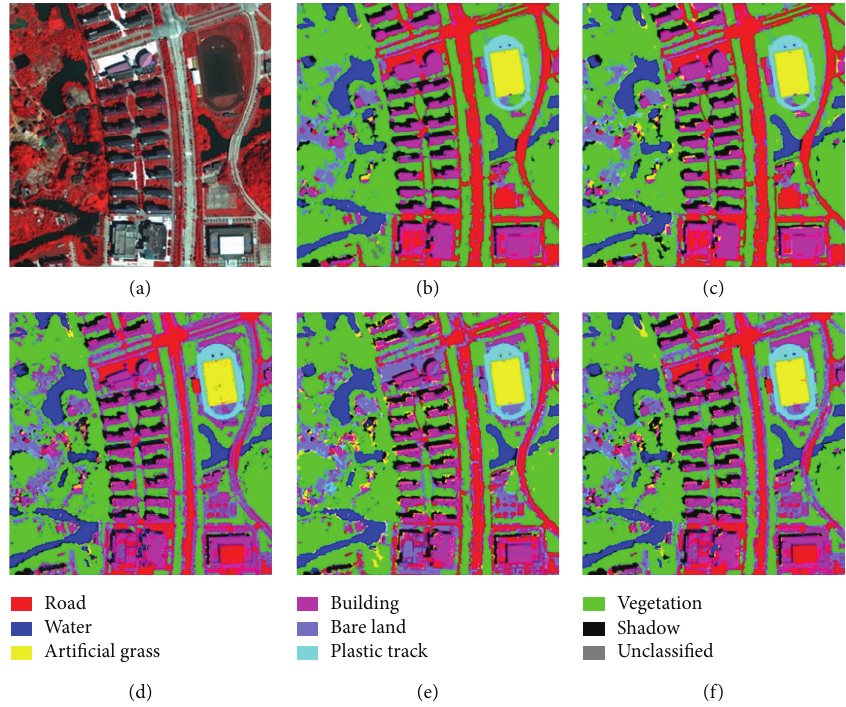
Figure 4: QuickBird images and classification results. (a) is the fused pseudocolor synthetic image, (b) is the primitive mapped classification image, (c) shows the final classification result obtained by the proposed method, and (d) is result of the pixel-based SVM. The classification result of the object-oriented SVM is shown in (e), and the SVMMV is shown in